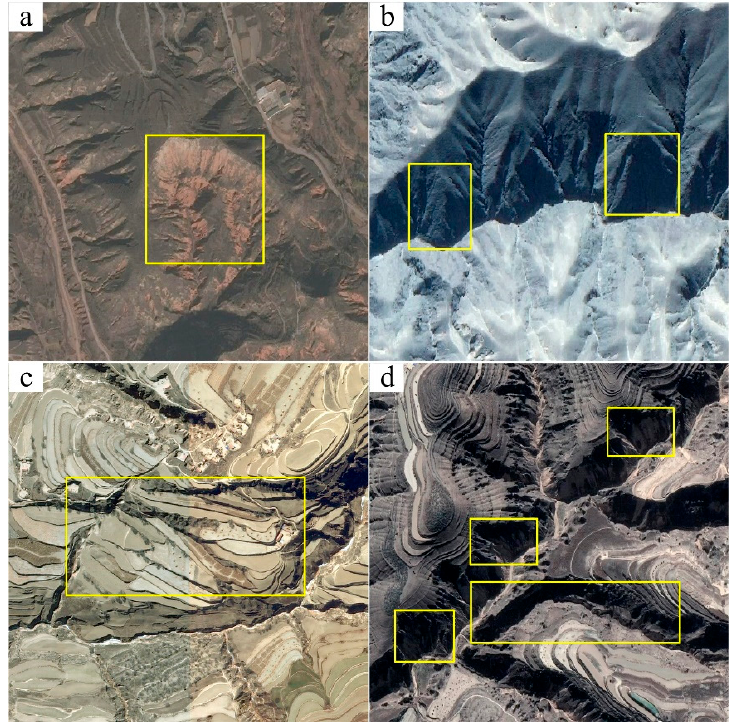
Figure 8. Example images showing false positive predictions: ( a ) in the valley; ( b ) in the shadow section; ( c ) in the terraces; ( d ) in the soil erosion section.